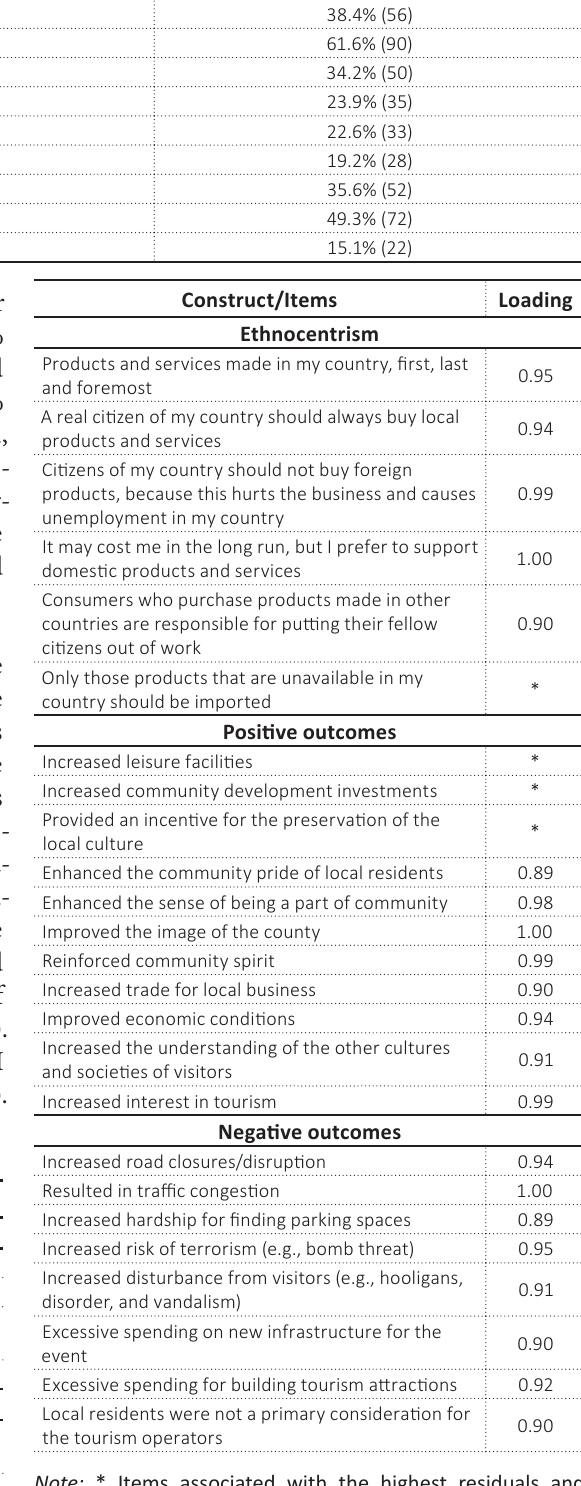
Table 1. Sample characteristics (n =